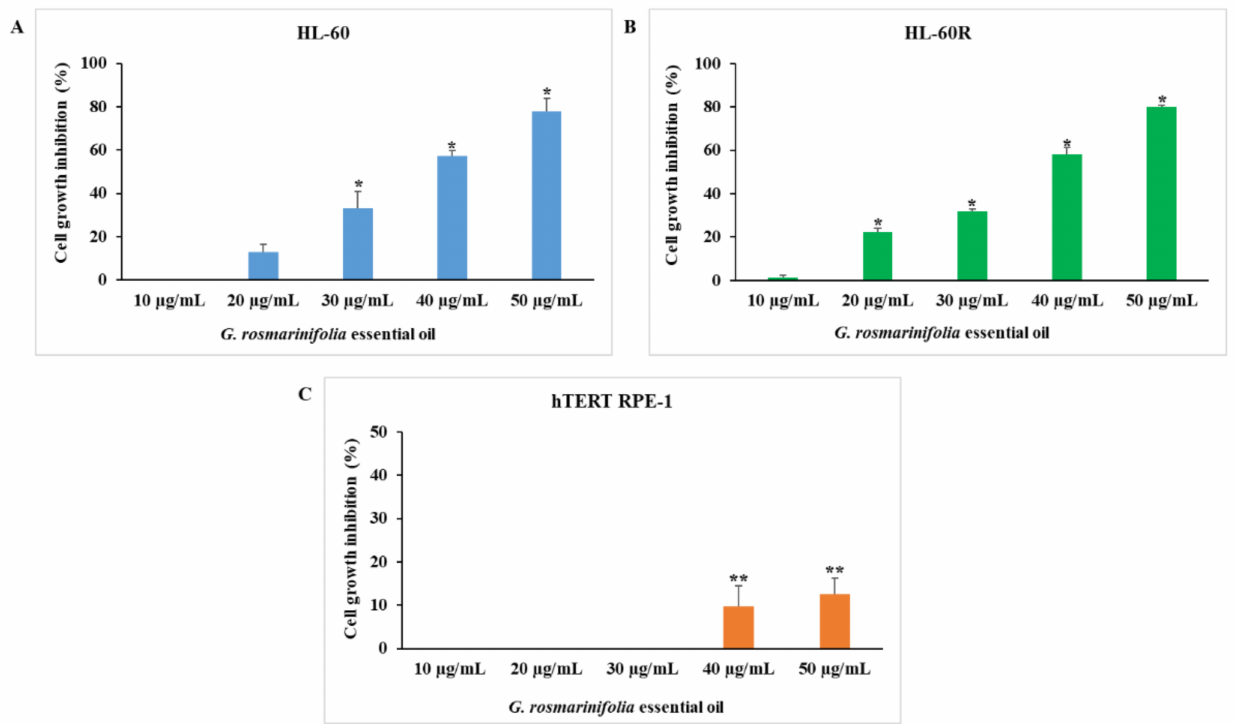
Figure 1. Cytotoxic activity of G. rosmarinifolia EO. Cell viability was assessed by MTS after 72 h of treatment at different concentrations. ( A ) HL-60 cell line; ( B ) HL-60R cell line; ( C ) hTERT RPE-1 cell line. Data are expressed as mean ± standard error (SE) of at least three different experiments performed in triplicate. Differences when treatments are compared to the controls: * p < 0.001; ** p < 0.05 (one-way ANOVA followed by Tukey’s test).